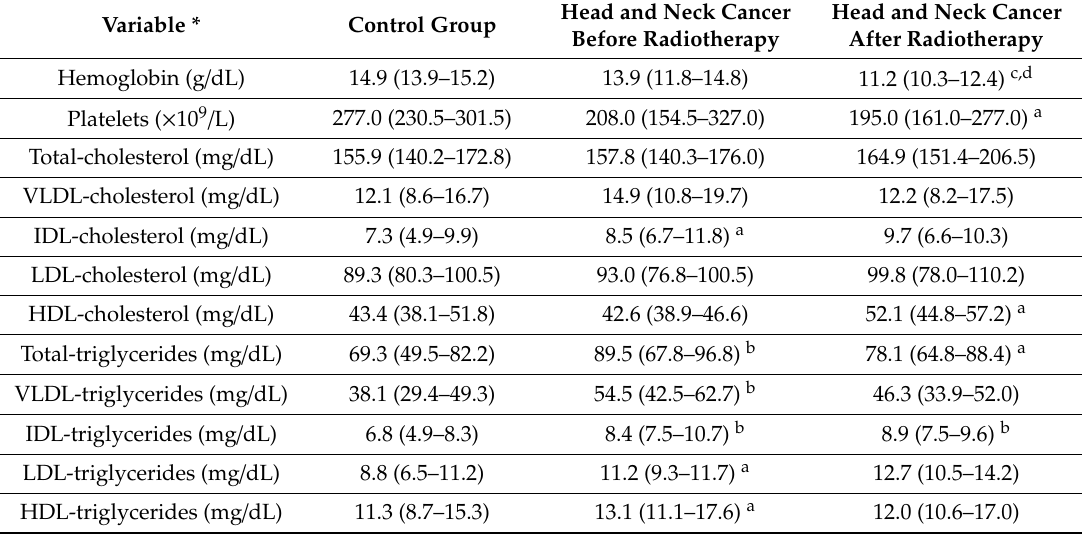
Table 5. Hematological variables and plasma cholesterol and triglycerides concentrations in head and neck cancer patients before and after